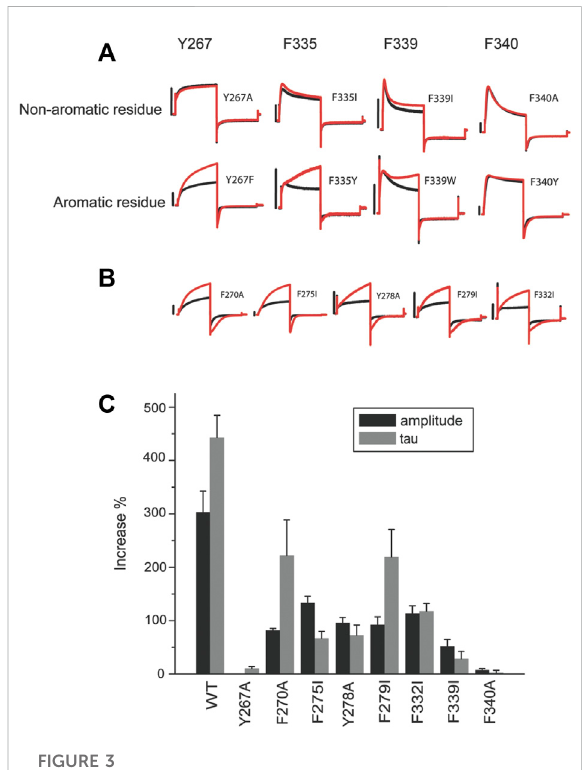
FIGURE 3 Aromatic residues in a putative hydrophobic pocket are important for ML277activity. (A) Y267, F335,and F340 arerequired for ML277 effect. Representative recordings of KCNQ1 Y267, F335, F339, and F340 mutated to non-aromatic residues (top panel) and aromatic residues (lower panels) before (black) and after (red) application of ML277. (B) Representative recordings of other aromatic residues in KCNQ1 mutated to non-aromatic residues before (black) and after (red) application ofML277. (C) Bar graphsummarizingtheeffectofML277oncurrentamplitude(grey bar) and deactivation kinetics (black bar) of all the mutants tested. The scale bar in the fi gure is a 1 s time